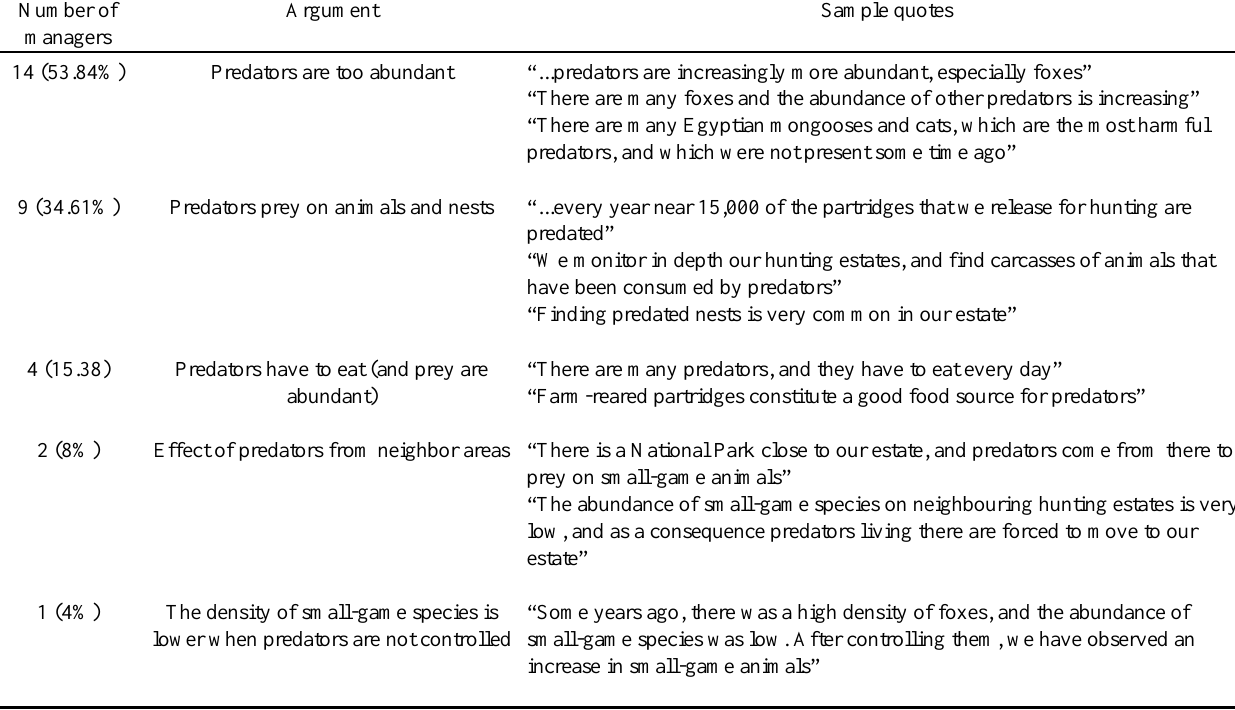
Table 2 . Main arguments given by managers to support their belief that predators negatively affect small-game species; arguments revealed from 26 qualitative interviews. Note that some managers gave more than one argument.